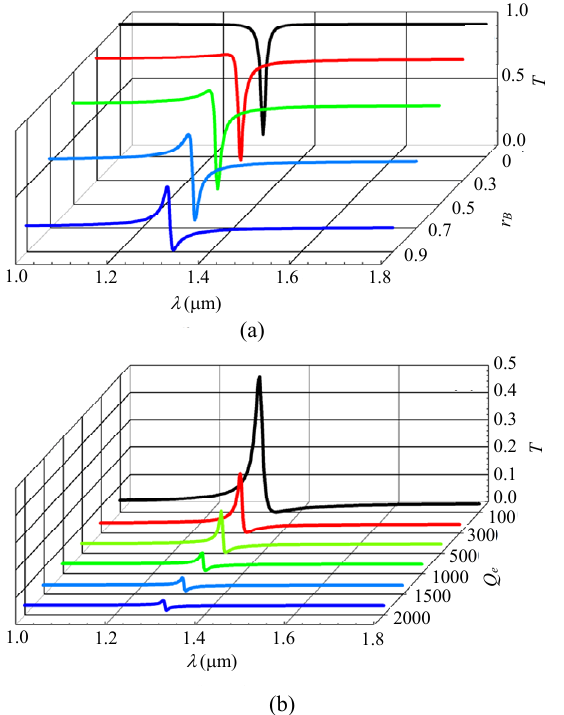
Fig. 2 Evolution of transmission spectra of the proposed structure: (a) transmission spectra of the proposed structure as a function of wavelength for different reflectivity amplitude, where Q A =300 and Q e =100 and (b) transmission spectra of the proposed structure as a function of wavelength for different value of quality factor Q e , where Q A =300 and r B